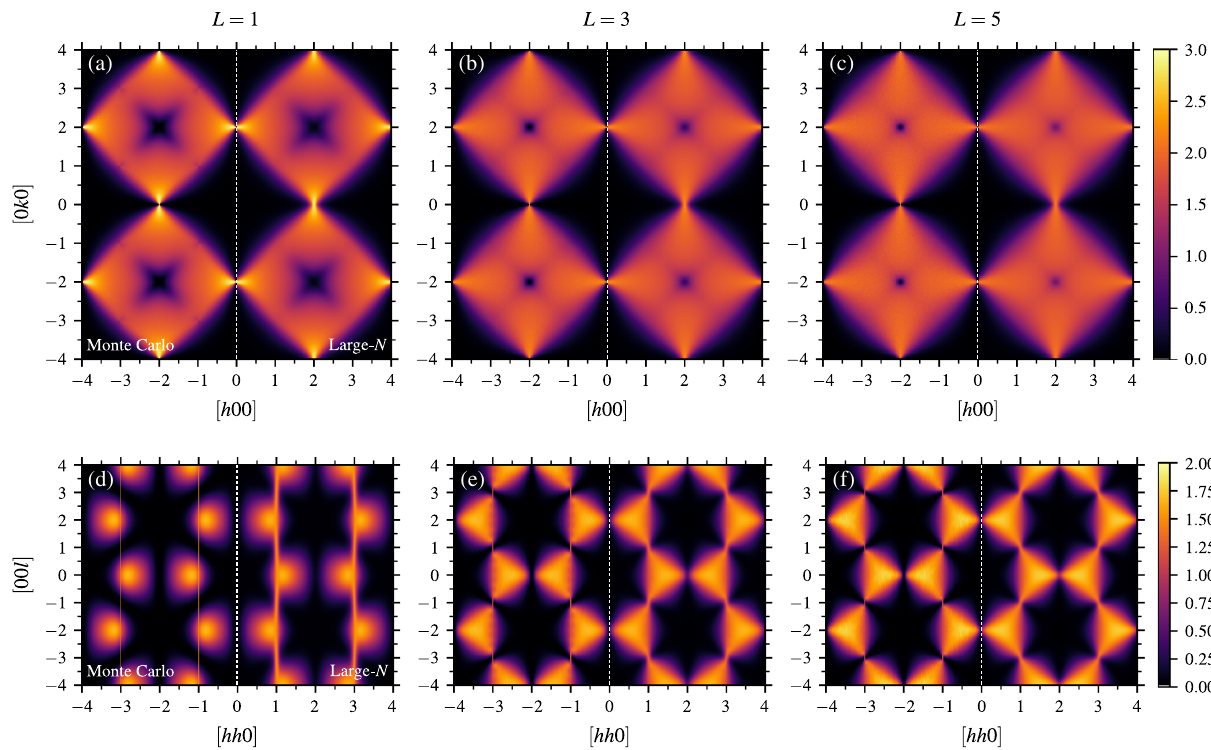
FIG. 6. Spin-spin correlation functions S ð q Þ [from large- N (right) and Monte Carlo (left)] of spin-ice films of thickness (a,d) L ¼ 1 , (b,e) L ¼ 3 , and (c,f) L ¼ 5 , for a temperature of T=J ¼ 0 . 1 in the (a – c) ½ hk 0 (cid:3) and (d – f) ½ hhl (cid:3) planes. Monte Carlo simulations were performed with L ⊥ ¼ 64 (for L ¼ 1 ) and L ⊥ ¼ 32 (for L ¼ 3 , 5). For T=J ¼ 0 . 1 , the large- N results are (effectively) in the thermodynamic limit ( L ⊥ → ∞